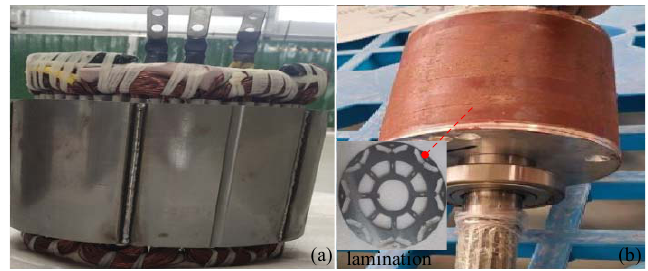
Figure 13. IPMSM component. ( a ) Stator, ( b ) rotor.